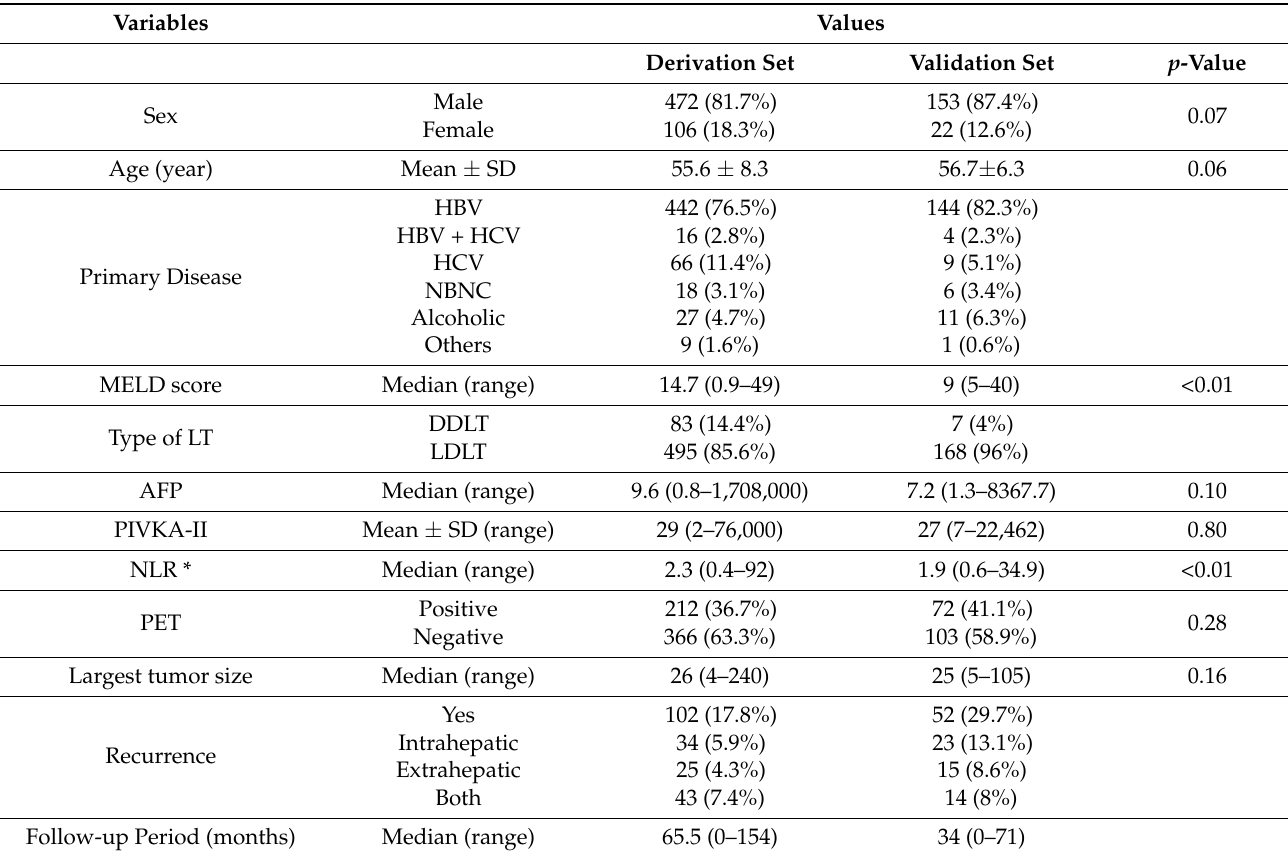
Table 1. Demographic data of the derivation and validation set.